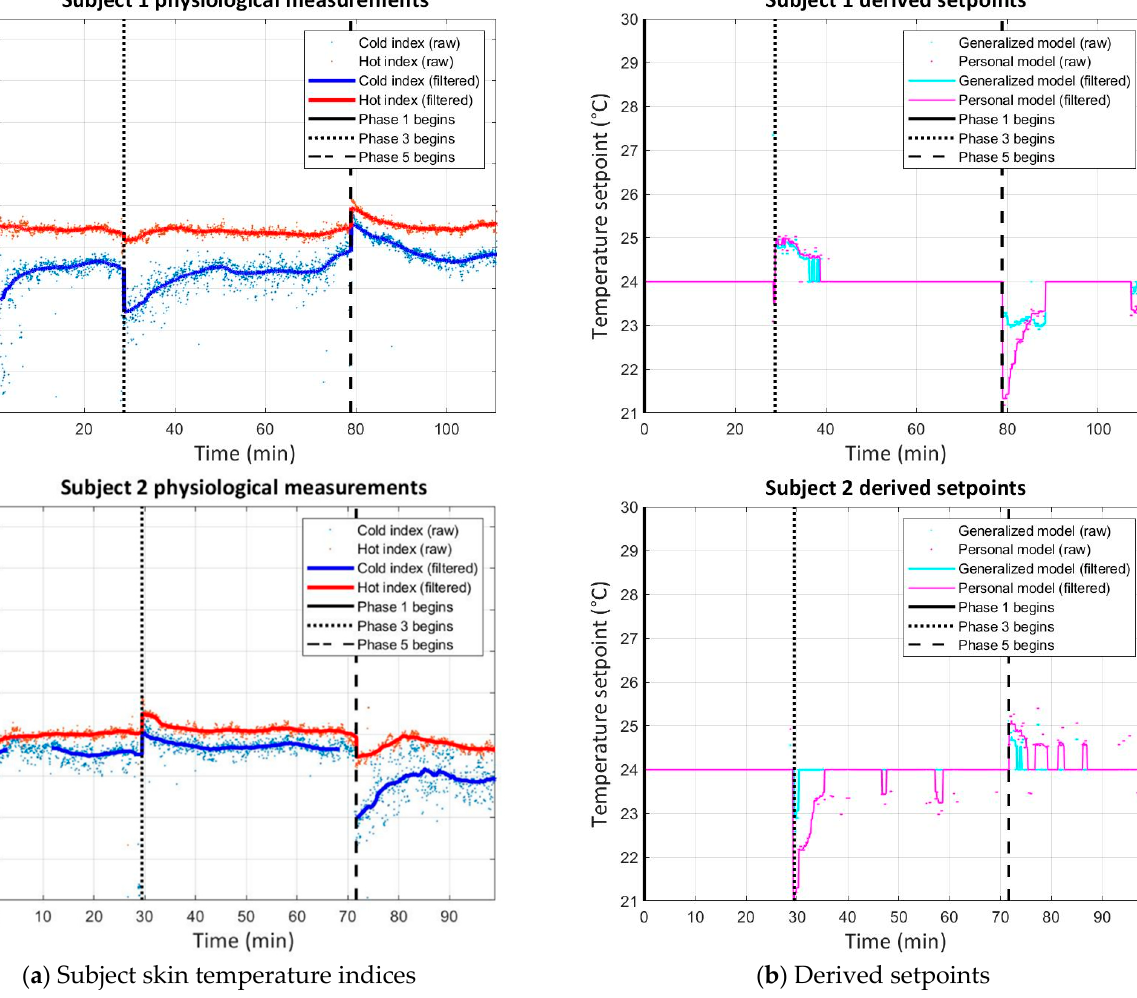
Figure 5. Skin temperature indices collected and derived setpoints showing cooling in Phase 3 and heating in Phase 5 for Phases 1, 3, and 5 with HVAC system running. Table 4. Cooling and heating verification results for warm and cool exposure using personalized and generalized